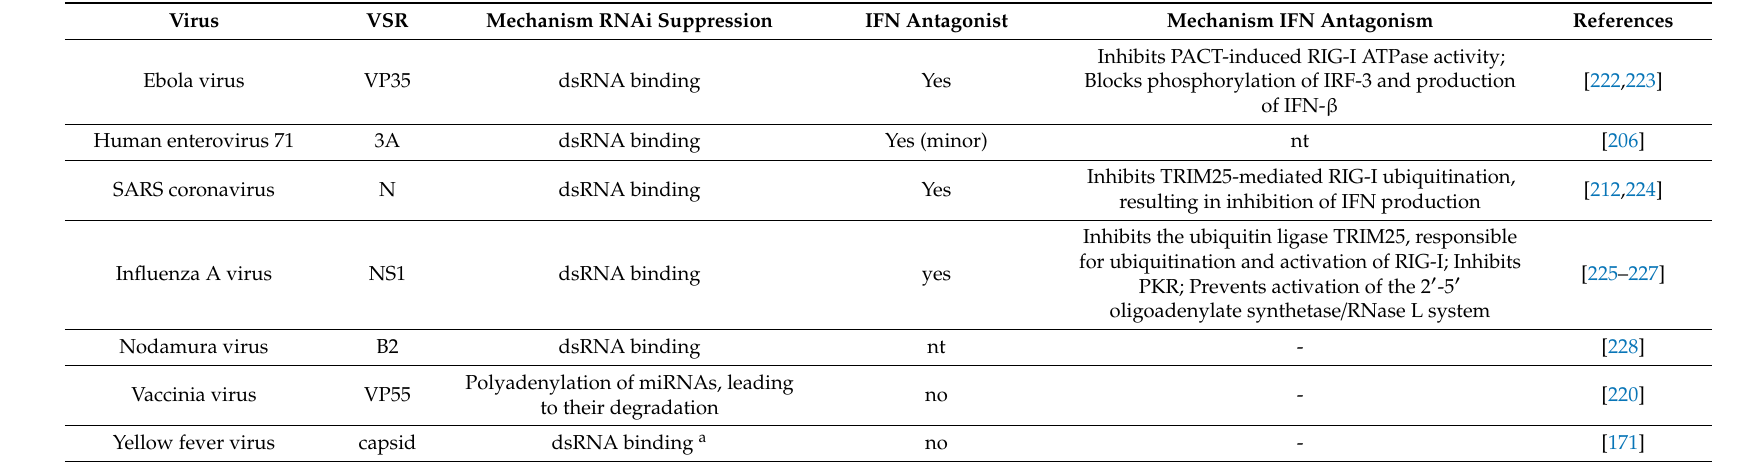
Table 2. Examples of viral suppressors of RNAi in mammalian